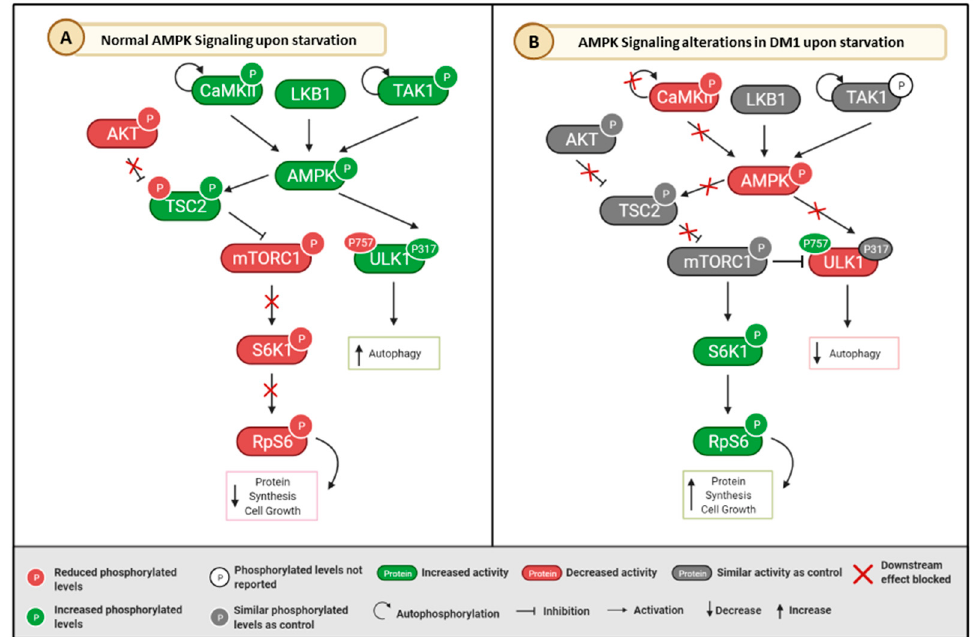
Figure 5. Schematic representation of the proposed mechanism of AMPK signaling dysfunction in DM1. ( A ) Normal AMPK signaling pathway; ( B ) AMPK Signaling alterations in DM1 upon